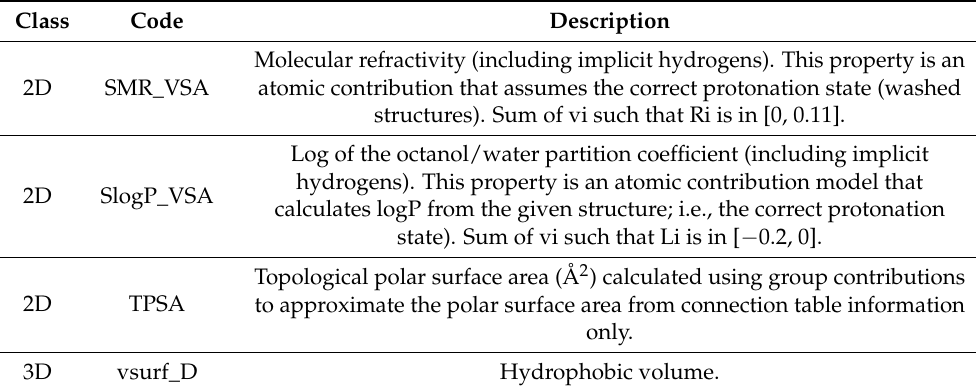
Table 3. Description of the molecular descriptors used for QSAR model generation for the neuropro- tective activity of